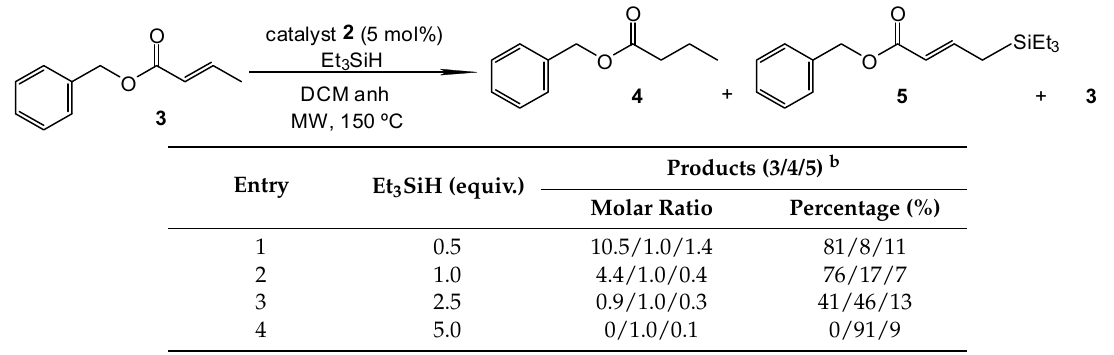
Catalysts 2017 , 7 , 111 3 of 13 Table 1. Along with the desired reduction product ( 4 ), an unexpected silylated compound, the benzyl (4-triethylsilyl)- trans - crotonate ( 5 ), was formed. Table 1. Reduction of trans ‐ benzyl crotonate ( 3 ) with triethylsilane catalyzed by 2 a Table 1. Reduction of trans -benzyl crotonate ( 3 ) with triethylsilane catalyzed by 2 a .